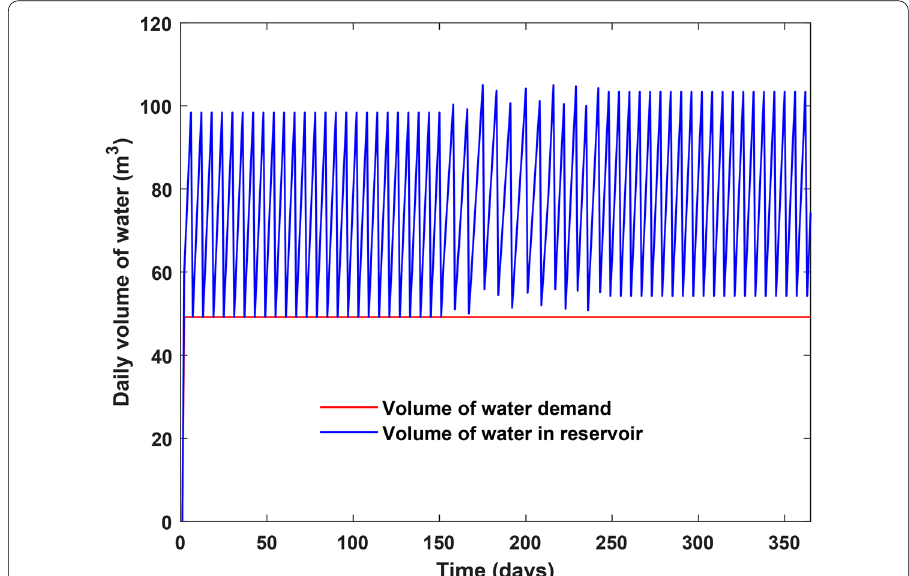
Fig. 14 Comparison between time variation in water supply and water demand for the optimal configuration corresponding to LWSP of 0%